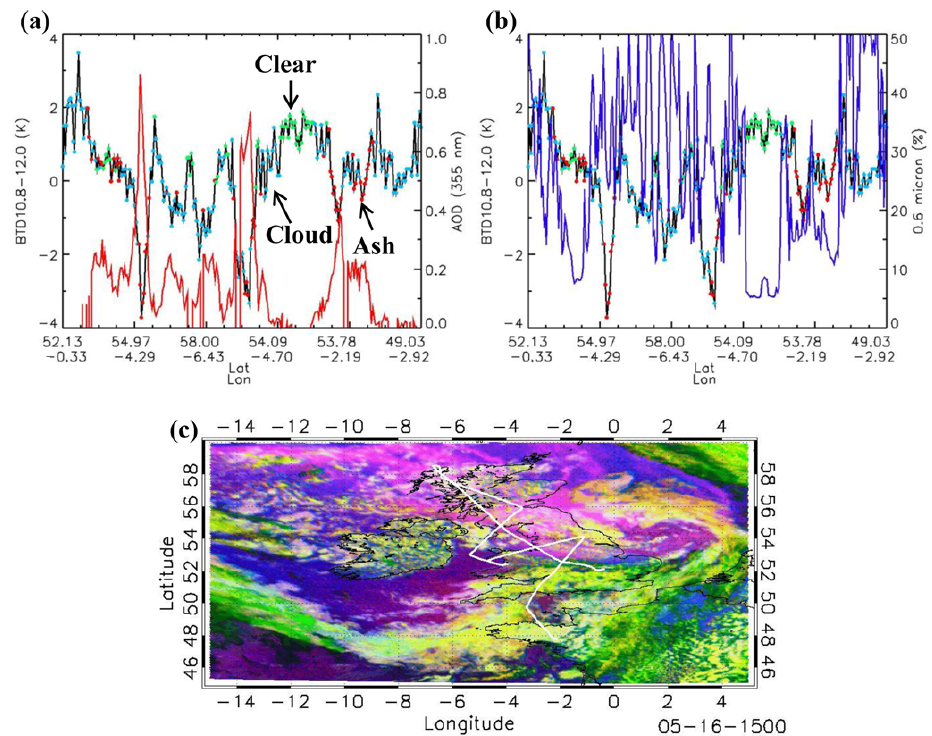
Fig. 6. (a) 355nm AOD from the BAe146 aircraft in red with the corresponding AOD scale on the right y axis and SEVIRI BTD 10.8–12.0 in black with its scale on the left y axis. The dots along the black line indicate the results from the SEVIRI algorithm along the aircraft flight, with green, blue, and red denoting clear, cloud, and aerosol, respectively. (b) SEVIRI BTD 10.8–12.0, again in black, along with 0.6µm reflectivity in blue with its scale on the y axis from 0 to 50%. (c) SEVIRI RGB image on 16 May at 15:00UTC with the intricate BAe146 aircraft flight track shown in